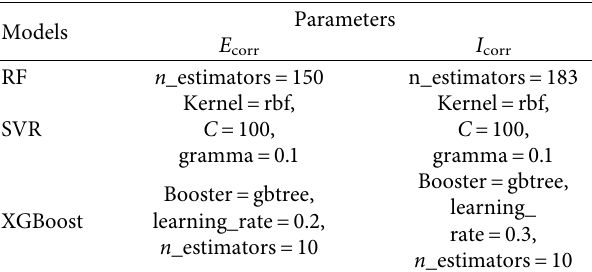
Table 3: Optimization parameters of each algorithm (other pa- rameters are